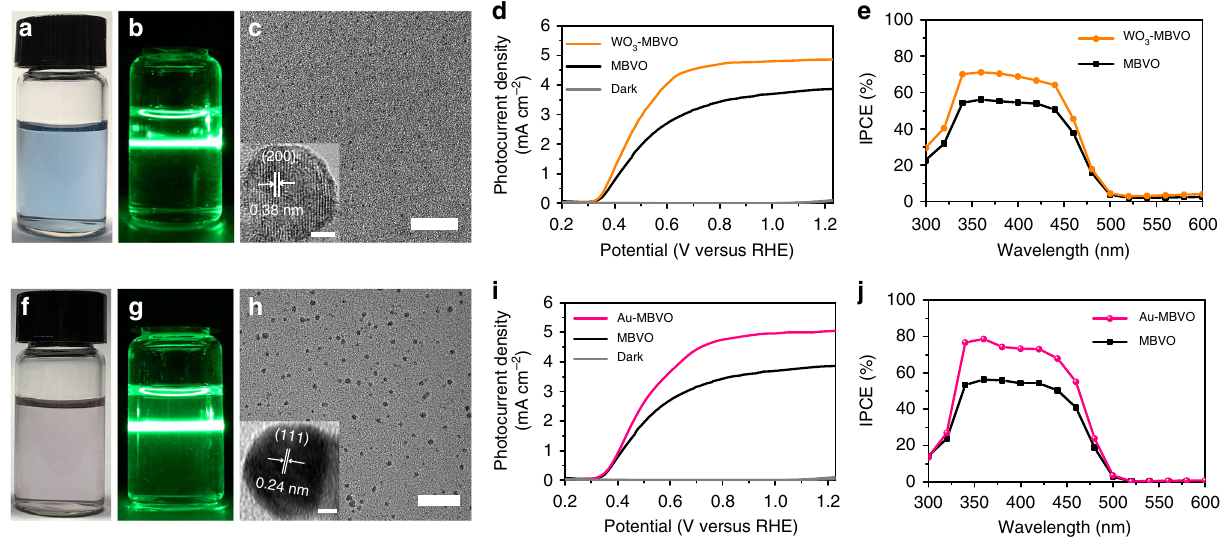
Fig. 4 Characterizations of WO 3 and Au nanocrystals and performance of WO 3 -MBVO and Au-MBVO fi lms. a Optical image of laser generated WO 3 colloidal nanocrystals with the mixed solvents. b Mie-scattering images of laser generated WO 3 colloidal nanocrystals. c TEM and HRTEM images of laser generated WO 3 nanocrystals. d J – V and e IPCE curves of MBVO and WO 3 -MBVO photoanodes. f Optical image of laser generated Au colloidal nanocrystals with the mixed solvents. g Mie-scattering images of laser generated Au colloidal nanocrystals. h TEM and HRTEM images of laser